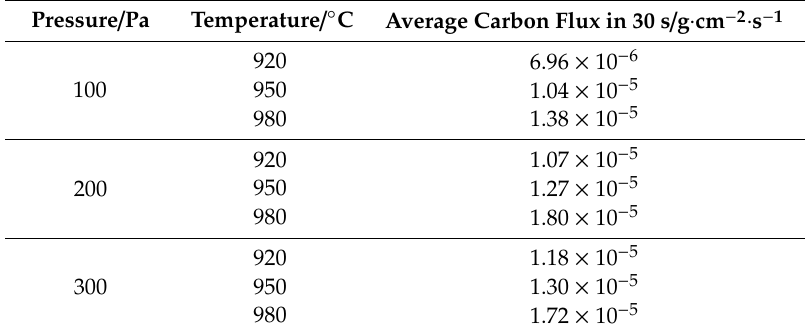
Table 2. E ff ect of carburizing temperature and pressure on average carbon flux of 12Cr2Ni4A steel.